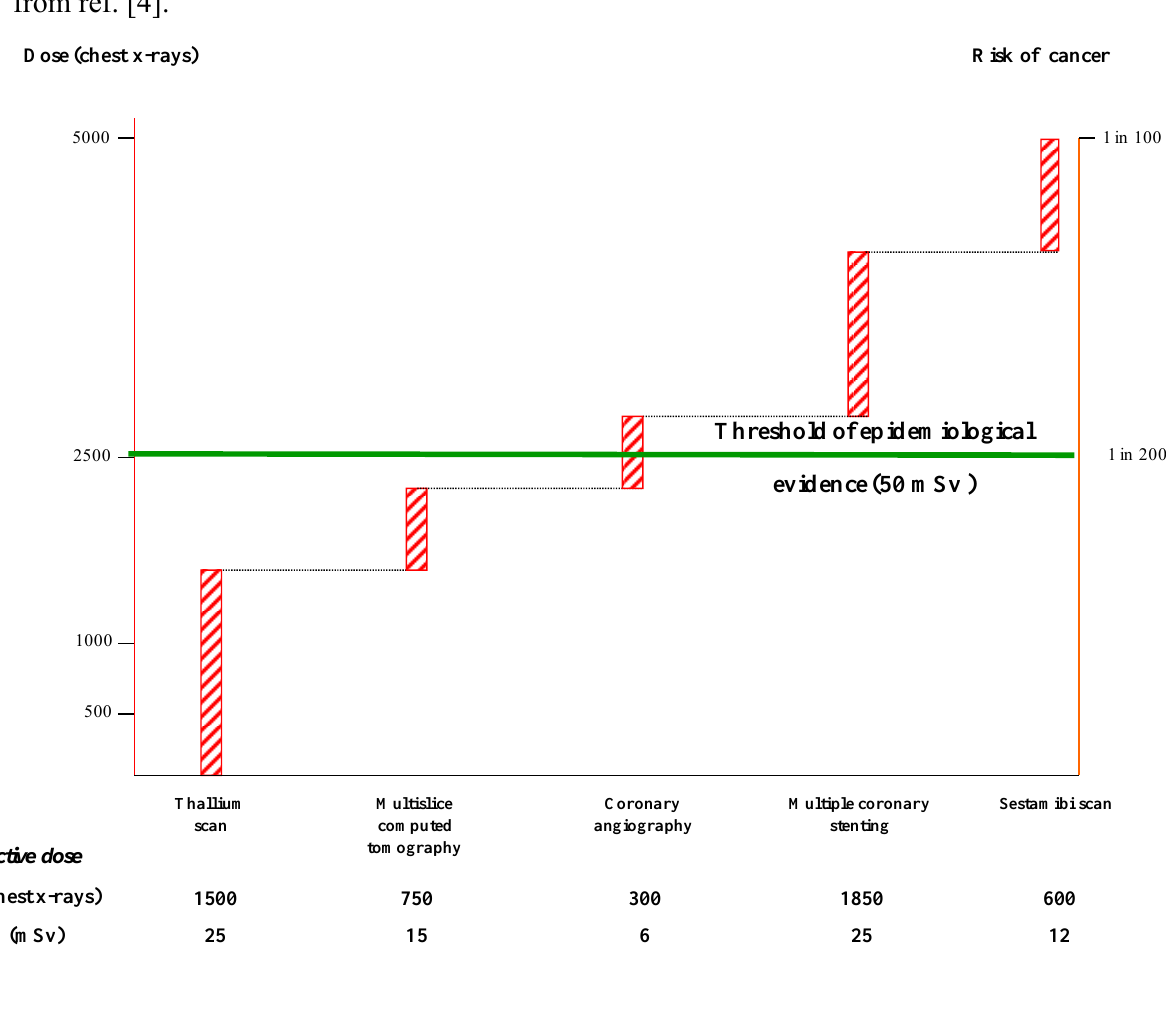
Figure 2. Graphical representation the cumulative exposure of doses in multiples of dose from a simple chest x ray (y axis, left) and corresponding cancer risk (y axis, right) cancer risk and radiation dose (in multiples of dose from a simple chest x ray) for a typical cardiological patients undergoing to five radiological examinations. Redrawn and modified from ref. [4].